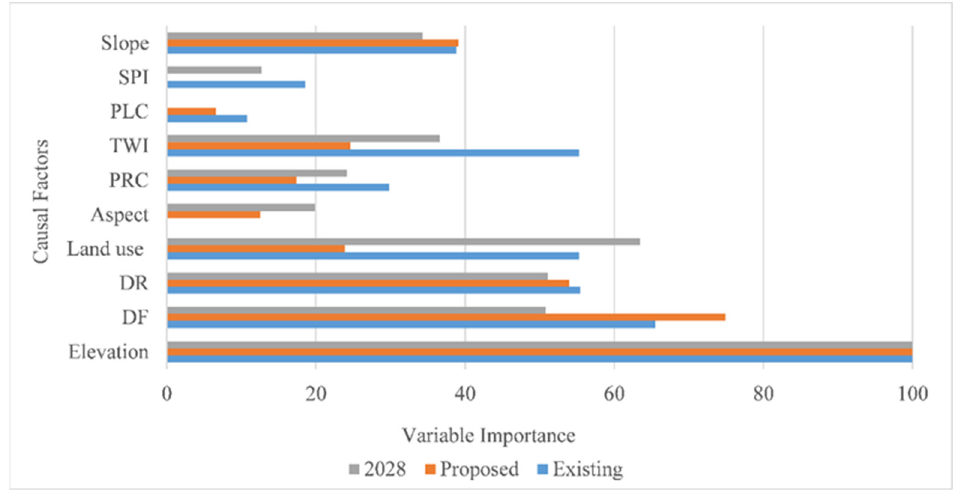
Figure 4. Variable importance plot for random forest models based on three LULC scenarios (SPI = stream power index; PLC = plan curvature; TWI = topographic wetness index; PRC = profile curvature; DR = distance from drainage; DF = distance from fault lines) .